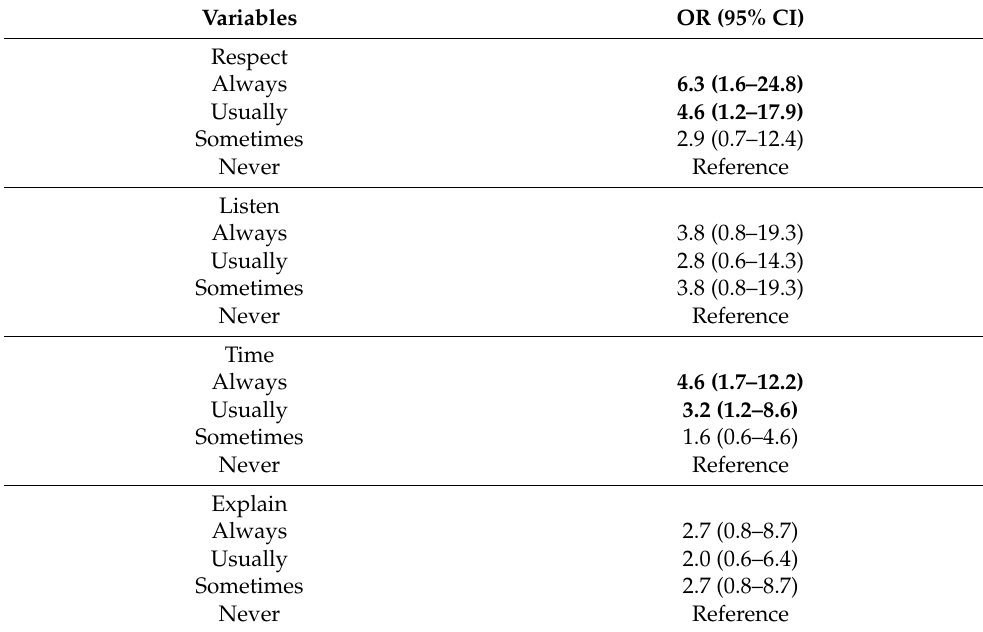
Table 2. Unadjusted odds ratios from the binary logistic regression for the four models (respect, listen, time, and explain) to assess the association between patient–physician communication and good mental health